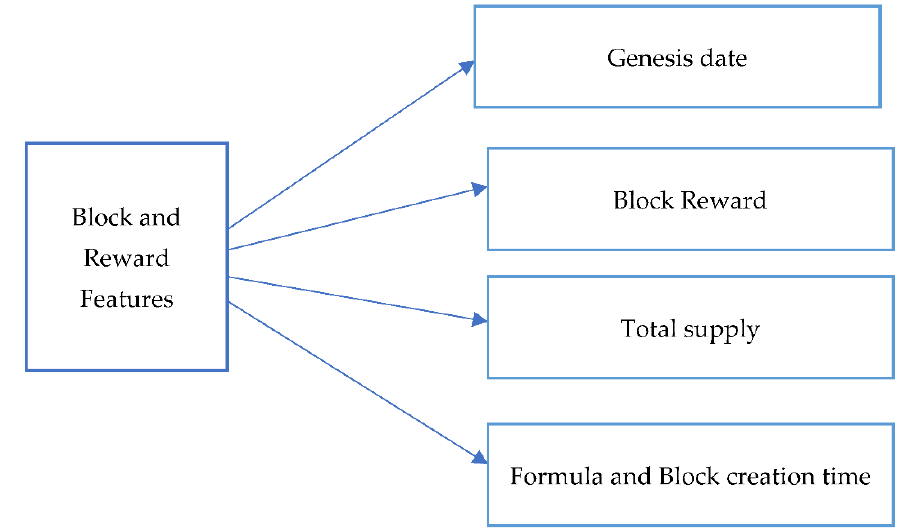
Figure 3. Subcategories of the block and reward features.